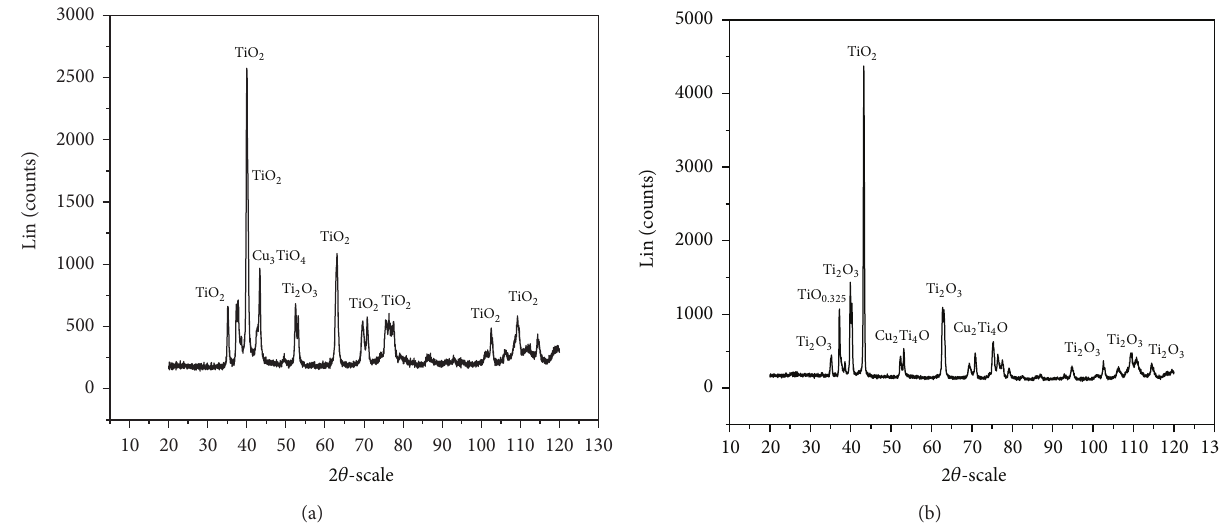
Figure 11: XRD pattern of the machined surface: (a) 𝑇 on = 1.1 𝜇 s, 𝑇 off = 28 𝜇 s, Ip = 200 A, SV = 50 V, WF = 7 m/min, WT = 500 grams; (b) 𝑇 on = 0.7 𝜇 s, T off = 28 𝜇 s, Ip = 120A, SV = 50 V, WF = 7m/min, WT = 500 grams.